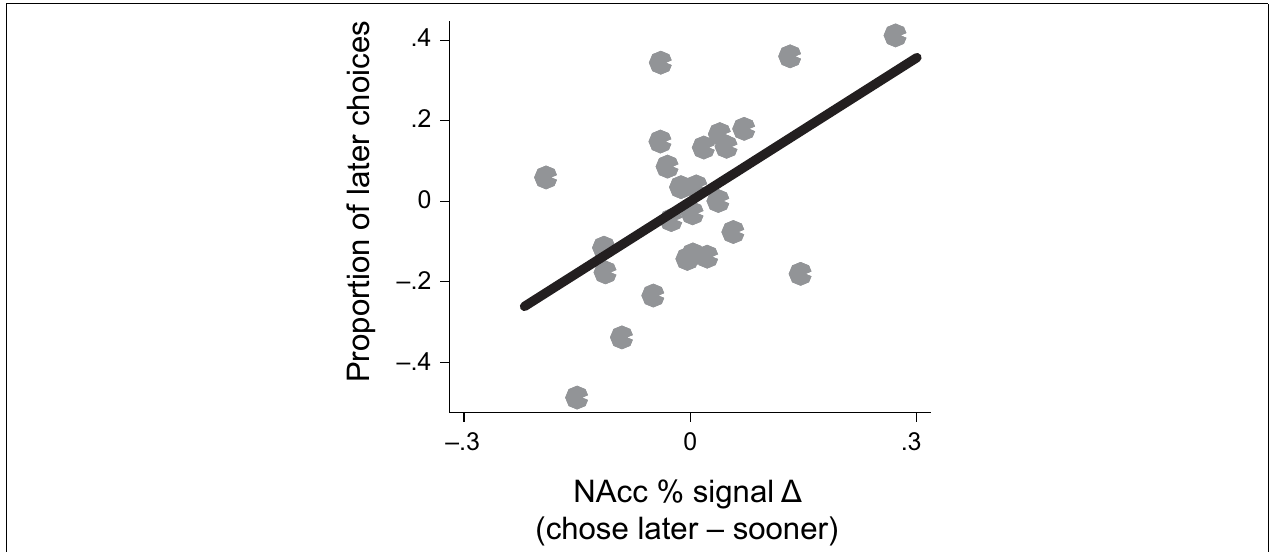
the NAcc on trials where they chose the later option relative to the sooner option also made more later choices overall, r = 0.54, p < 0.01 (controlling for